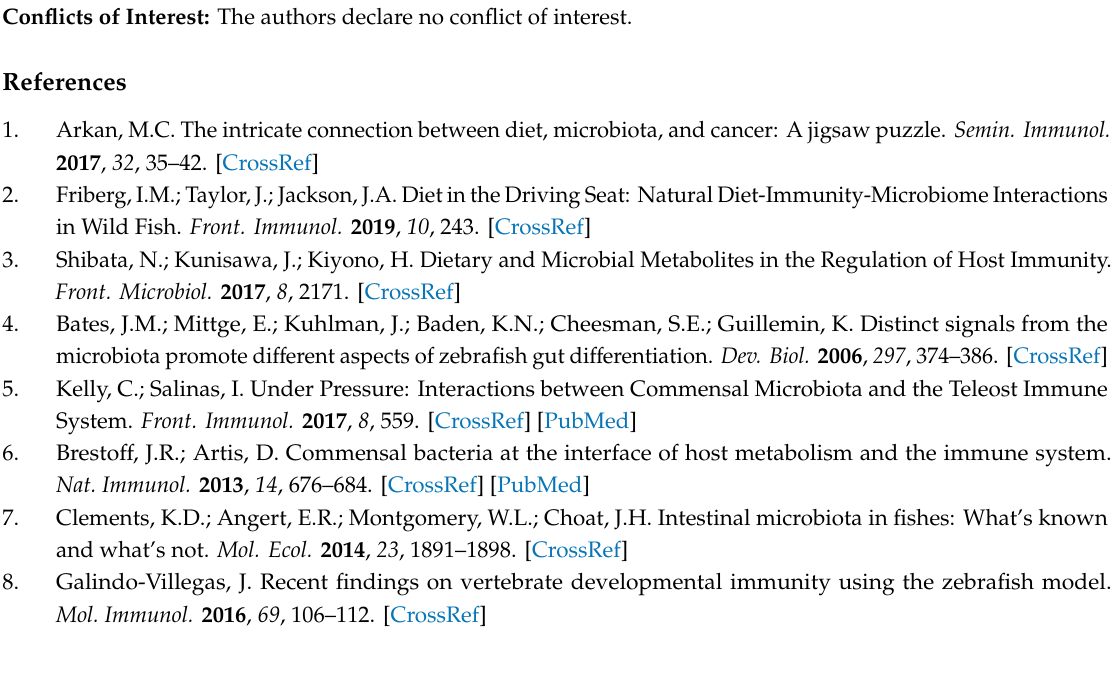
Table S1: Fatty acid composition and content of experimental diets. Table S2: Primers used in qRT-PCR. Table S3: Mean relative abundance of dominant taxa at various taxonomic levels. File S1: Code. File S2: OTU table. File S3: Barcode